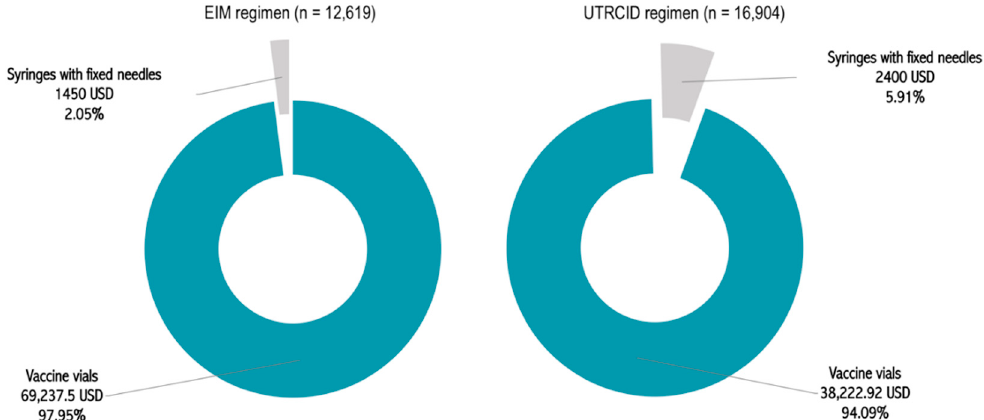
Figure 2. Costs borne by our hospital for providing rabies vaccination for a period of one year via the Essen intramuscular (EIM) regimen and updated Thai Red Cross intradermal (UTRCID) regimen. Costs are expressed in USD. n = number of patients.